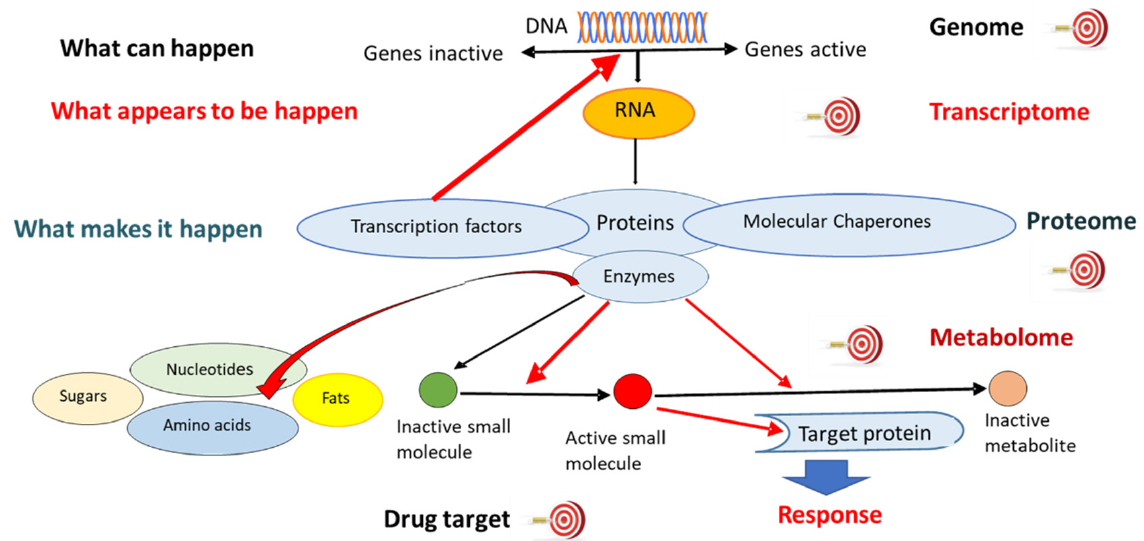
Figure 1. Flowchart showing the possible cellular and molecular targets for pharmacological intervention and the cell response after an active molecule binds its receptor at metabolomic, proteomic, transcriptomic, and genomic levels of regulation. Reprinted from Reference [5].